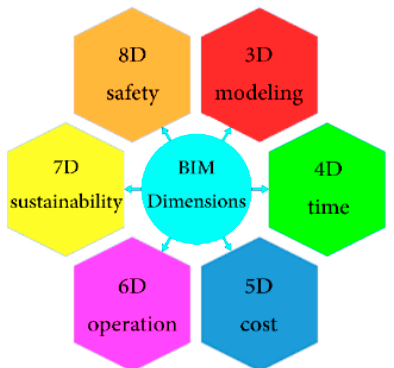
Figure 1. Building Information Modeling (BIM) dimensions.